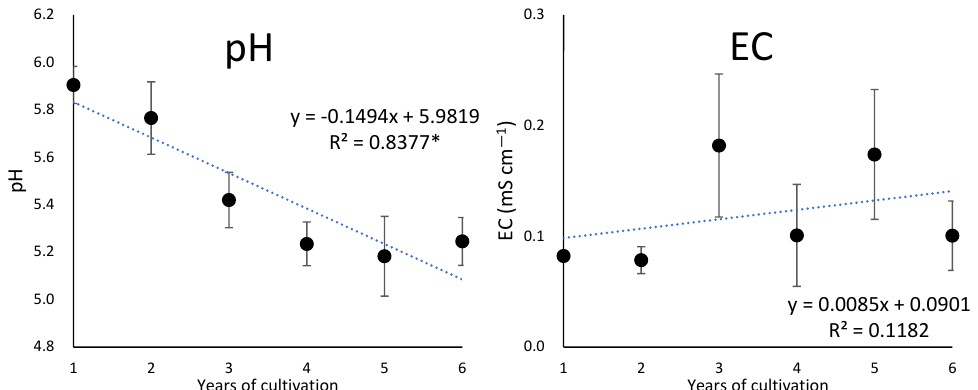
Figure 4. Relationships between years of ginseng cultivation and pH and EC in the soil. Mean values ± standard errors ( n = 3). * Represents significance at the 0.05 probability level.